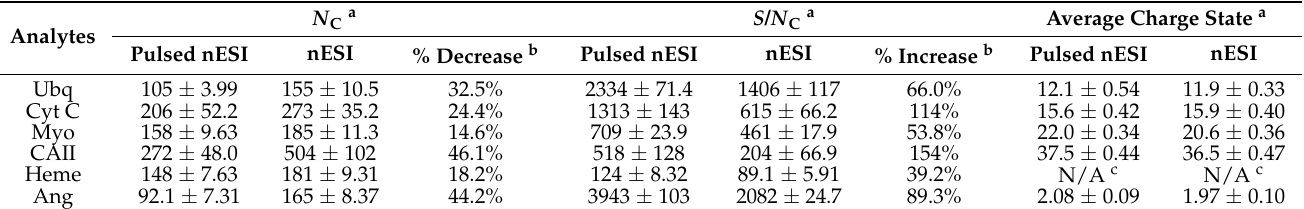
a Values correspond to the mean ± standard deviation of at least three replicate measurements; b p -value < 0.05; c Not